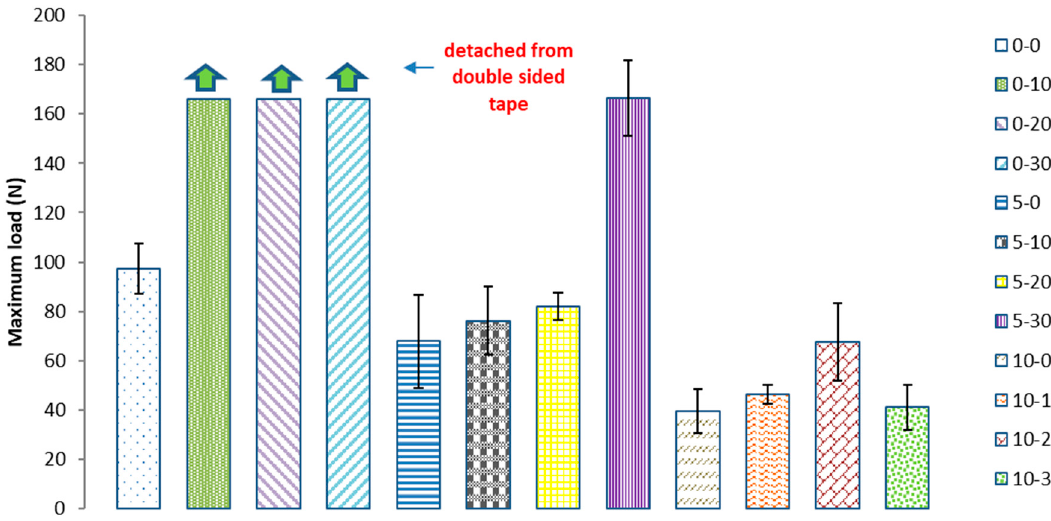
Figure 6. Strength of glued joints in starch-lignin adhesives.